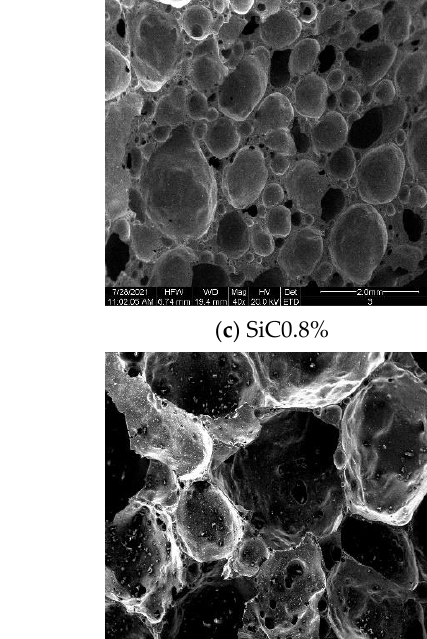
Table 3. Heavy metal concentration and the national standard.